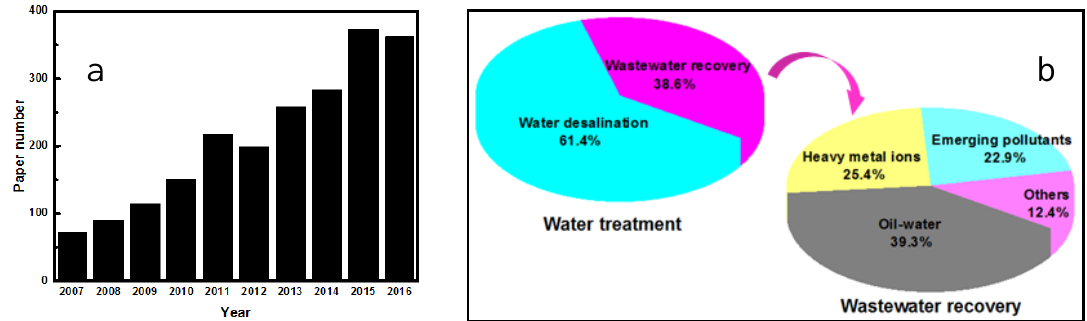
Figure 1. ( a ) Annual number of research papers for CNTs-based composite membranes reported during 2007-2016 (topic keyword “carbon nanotubes composite membranes” searched from Web of Science), all date updated on January 9, 2017; ( b ) Existing water treatment methods for CNTs-based composite membranes.